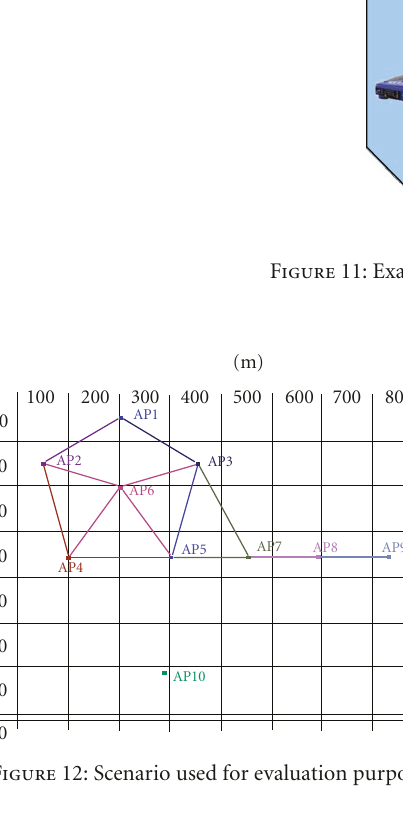
UDP tests show that tra ffi c from nodes AP7, AP8, and AP9 is now able to reach the destination, while node AP10 remains isolated as intended. Notice that, for the former nodes, the packet loss ratio increases slightly with the number of hops to destination. With ns-2 we do not observe this behaviour for the reasons referred